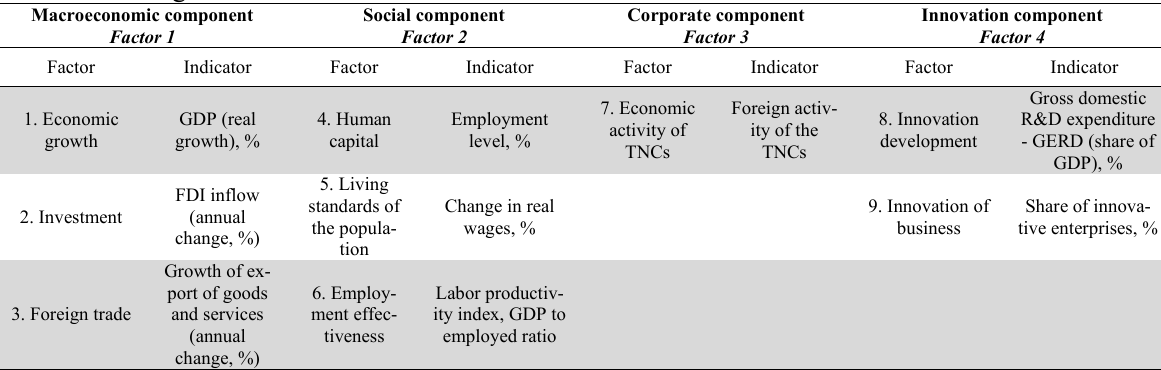
Social component Corporate component Innovation component Factor 2 Factor 3 Factor 4